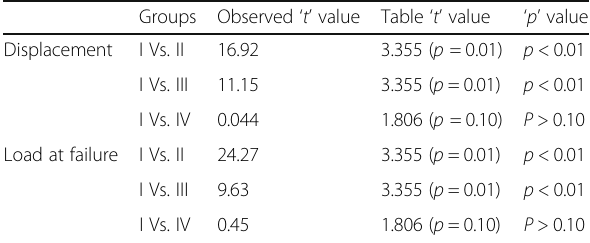
samples in Group I and Group IV had no asymmetric Table 2 Statistical analysis Groups Observed ‘ t ’ value Table ‘ t ’ value ‘ p ’